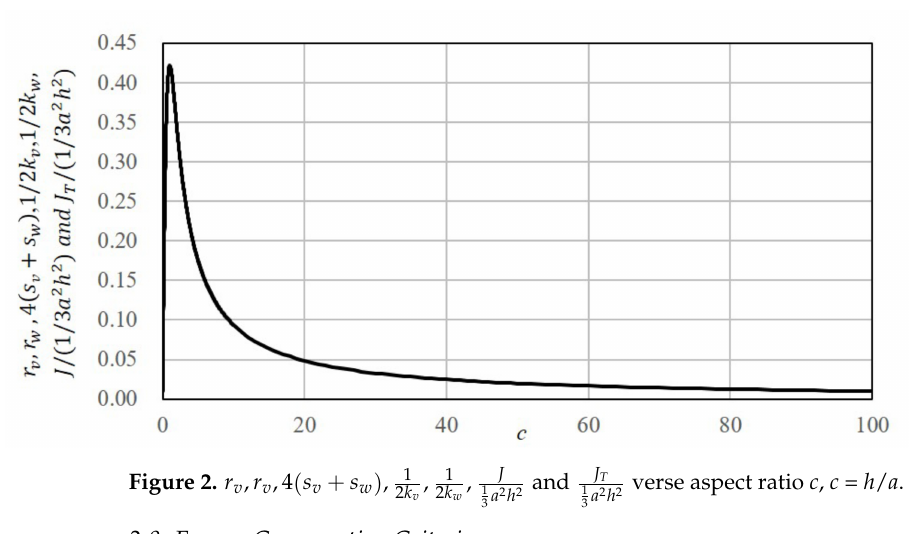
Figure 2. r v , r v ,4 ( s v + s w ) , 1